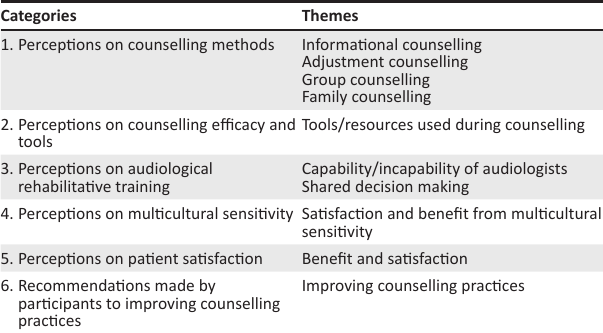
FIGURE 2: Concept map depicting themes developed within this TABLE 2: Representation of categories and themes found in the study.